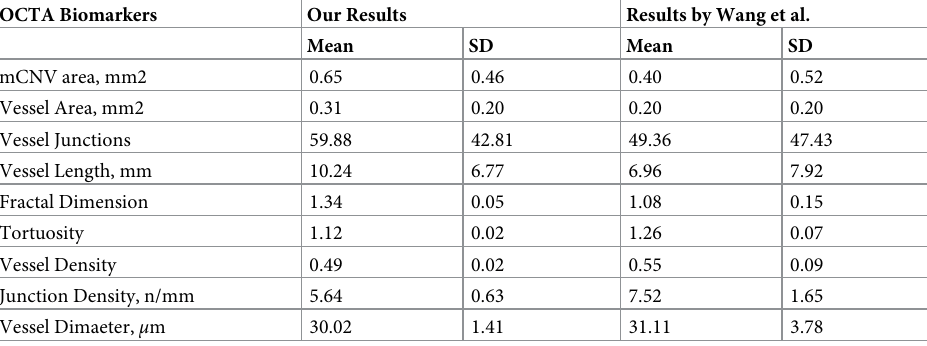
Table 3. Comparison of our results (26 images) with a similar study on mCNV (Wang et al. [1], 31 images). OCTA Biomarkers